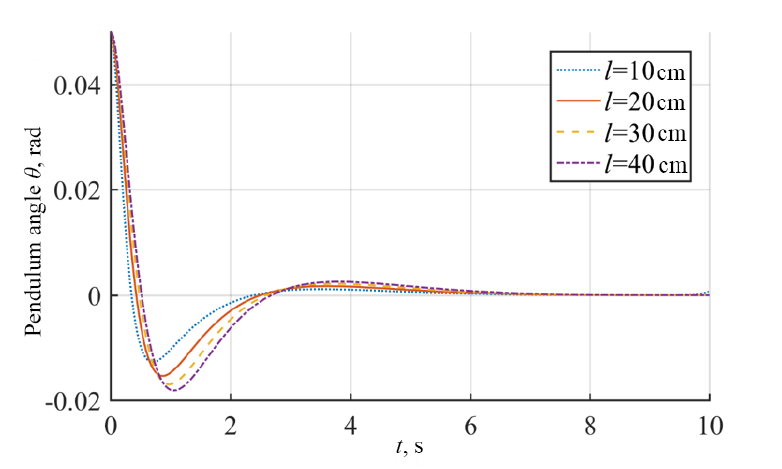
Figure 9. Pendulum angle θ at different l